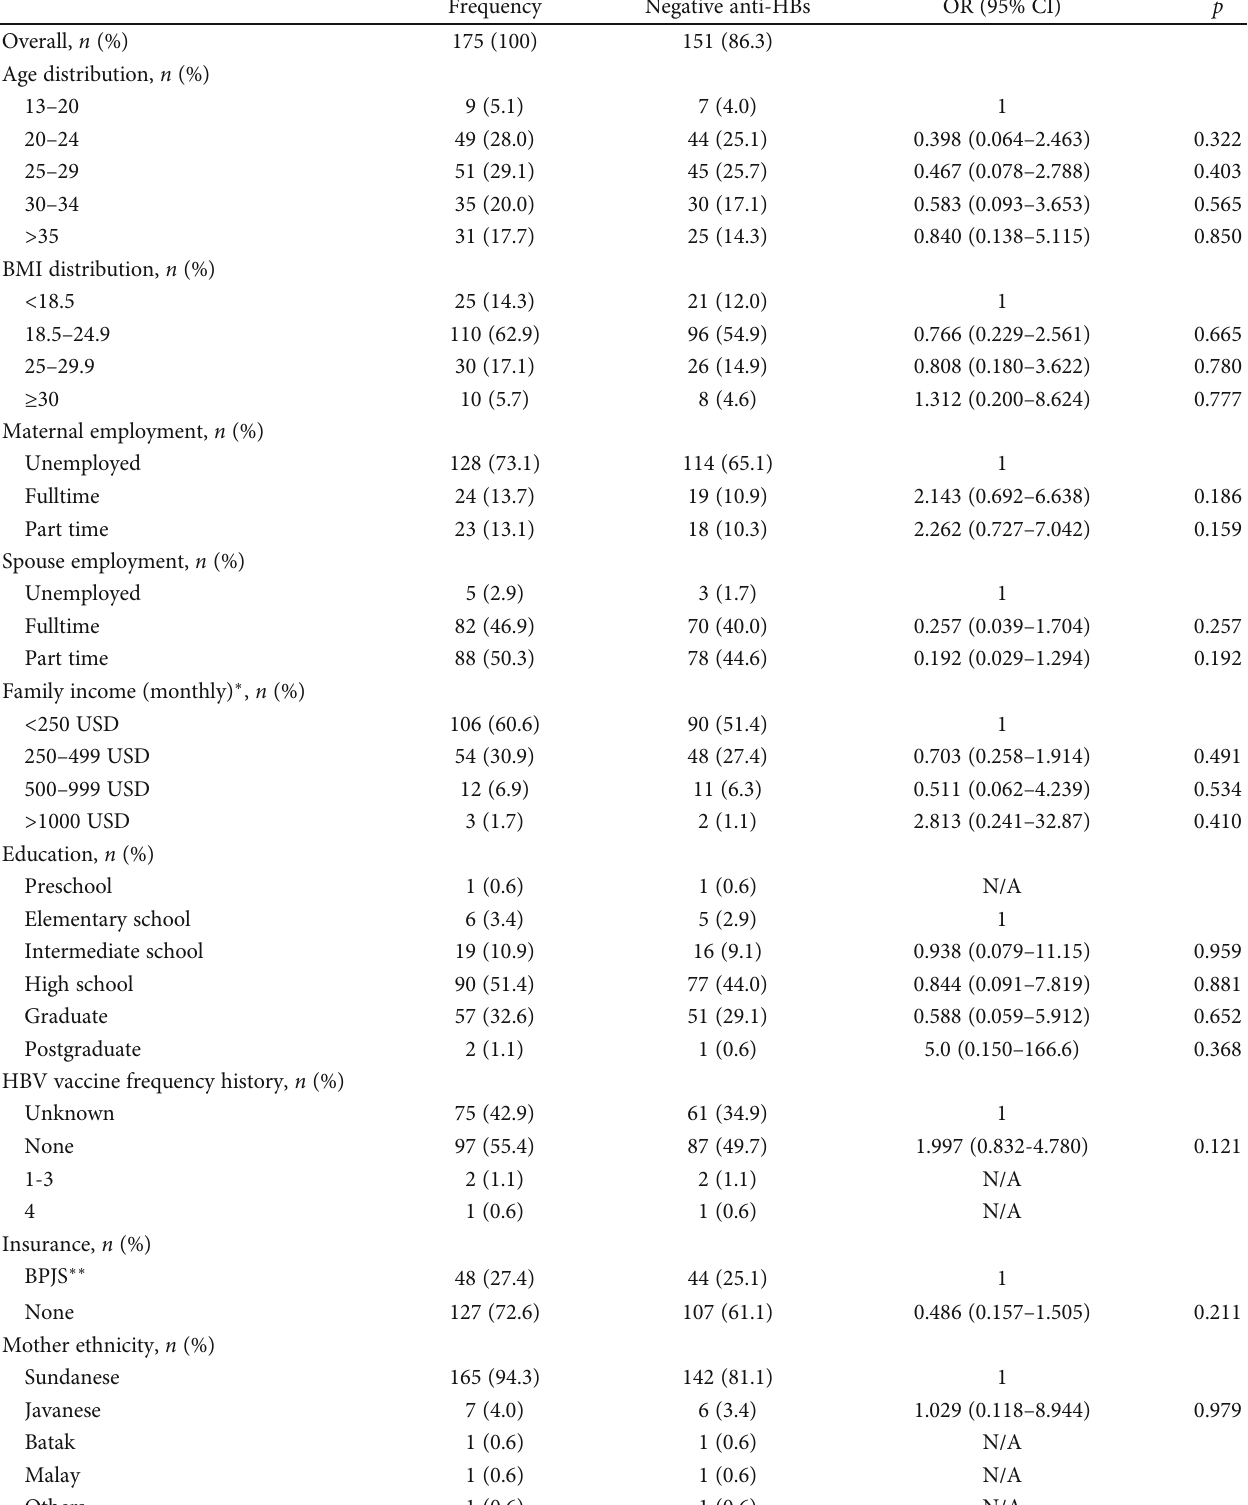
Table 3: Analyses of anti-HBs-negative subjects after excluding HBsAg- and Anti-HBc-positive